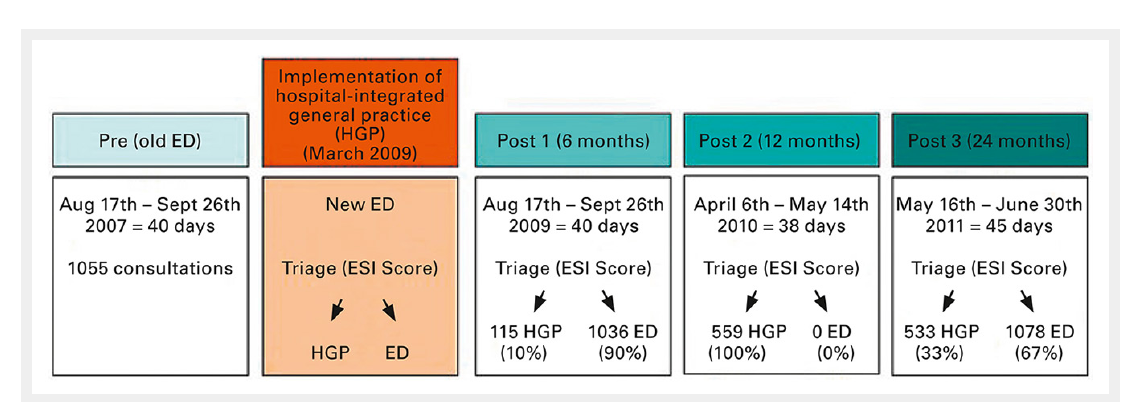
Study measurements at the ED and/or HGP. Study flow of different phases of data collection at the emergency department (ED) from August 17 th 2007 until June 30 th 2011. In 2007 baseline measurements at the old ED were performed before implementation of the hospital integrated general practice (HGP) in March 2009. In the new model patients presenting at the ED are triaged by a trained emergency nurse using the Emergency Severity Index score (ESI) to either the ED or the HGP. Follow up measurements at the ED and/or HGP were undertaken in 2009, 2010 and 2011. Since the HGP was implemented shortly before the evaluation period in 2009 only a selection of GPs at the HGP were questioned in that specific study period to reduce stress burden of the new system. In 2010 only measurements at the HGP were